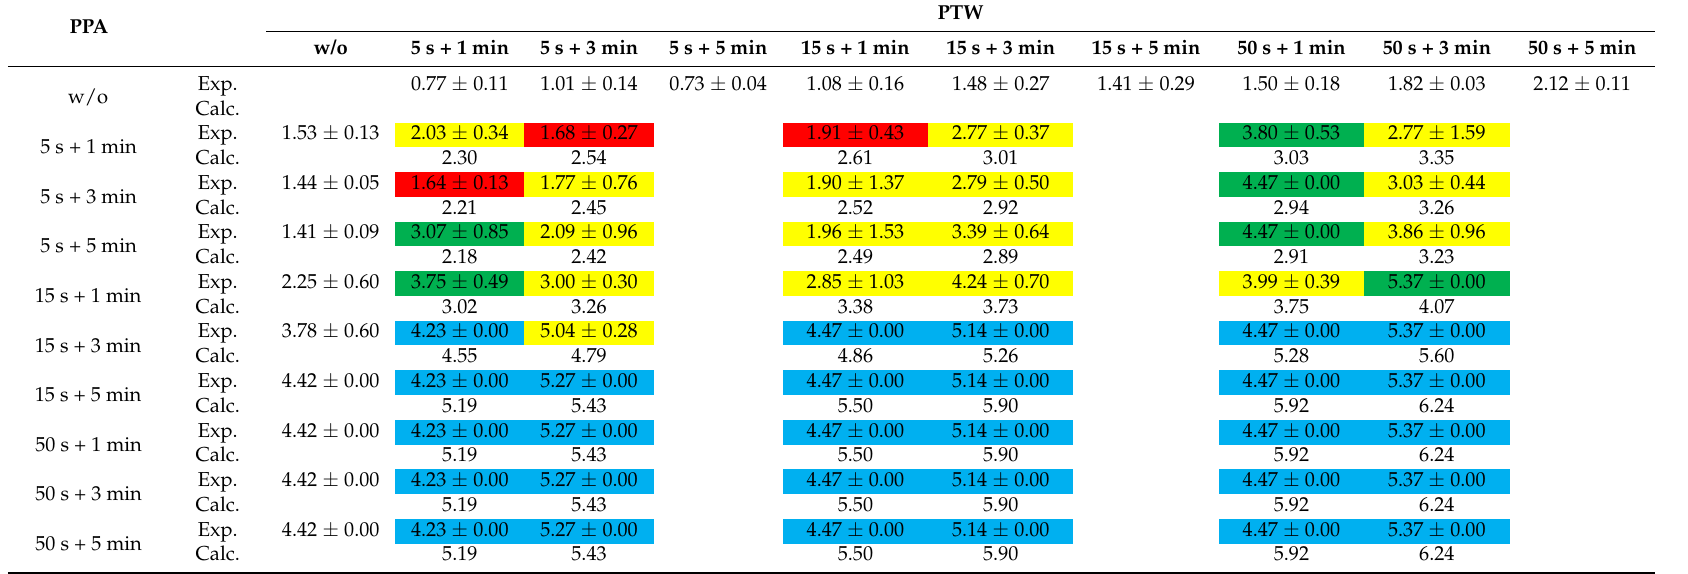
Table 5. Experimental and calculated data of a separated and combined use of PPA (plasma-processed air) and PTW (plasma-treated water) under different pre- and post-treatment times for antimicrobial effects on E. coli K12. Color code for effects of combined PTW/PPA treatments: red = antagonistic, yellow = additive, green = synergistic, blue = detection limit reached within the experiments. w/o = without. Exp. = experimental, Calc. = calculated. PPA